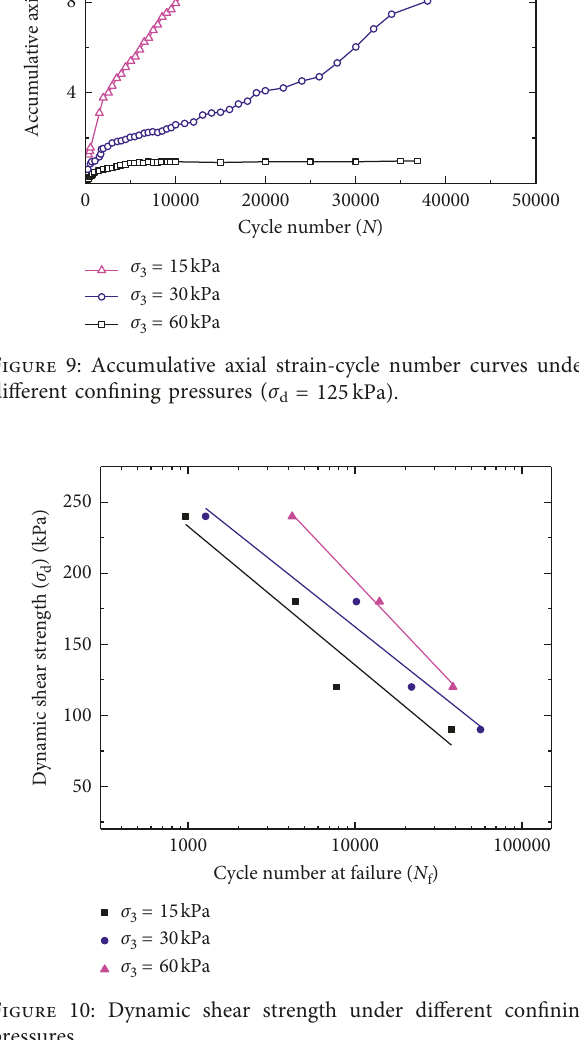
Figure 10: Dynamic shear strength under different confining